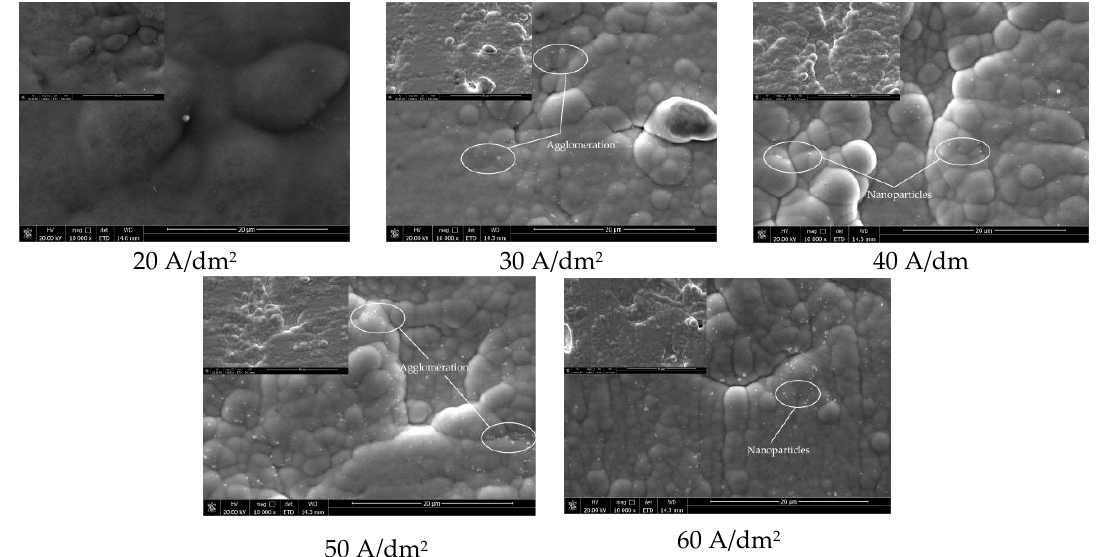
Figure 2. Surface micromorphologies of Ni–P–ZrO 2 –CeO 2 composite coatings prepared at different current densities.